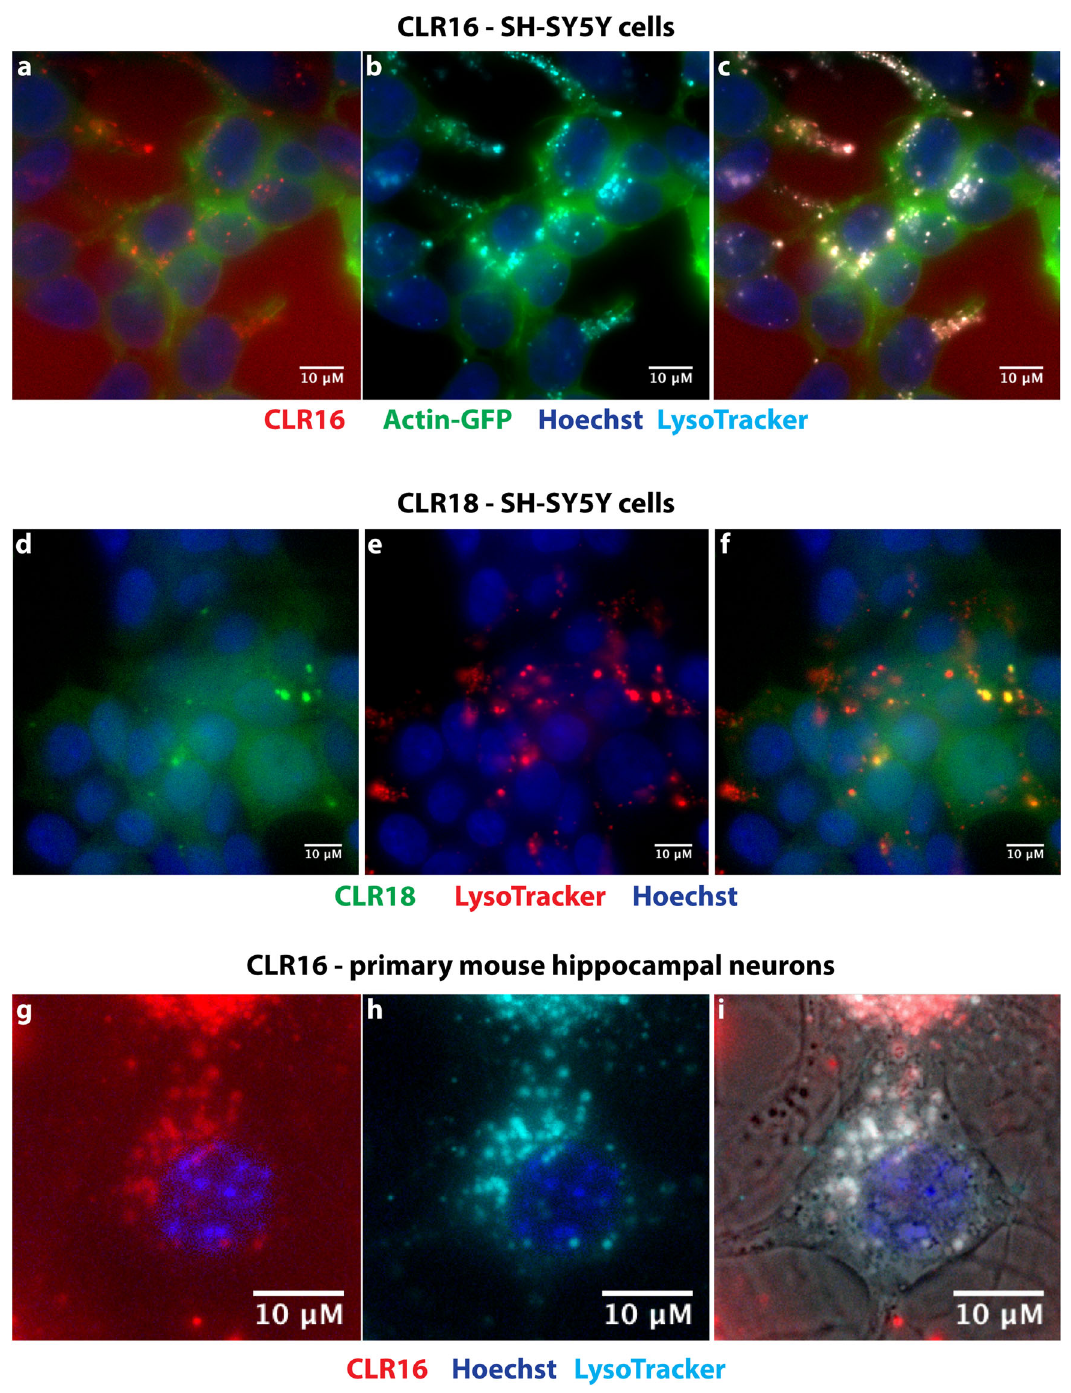
Fig. 4 MTs colocalize strongly with lysosomes in neurons. a SH-SY5Y cells were transiently transfected with GFP-actin, incubated with 5 µ M CLR16 for 24 h, and nuclei were stained with Hoechst. b Lysosomes were stained with LysoTracker ™ (pseudo-colored cyan). c Overlap of a and b shows strong colocalization of CLR16 with lysosomes. d SH-SY5Y cells were incubated with 10 µ M CLR18 for 24 h and nuclei were stained with Hoechst. e Lysosomes were stained with LysoTracker ™ (pseudo-colored red). f Overlap of d and e shows colocalization of CLR18 with lysosomes. g Primary mouse hippocampal neurons were incubated with 10 µ M CLR16 for 24 h and nuclei were stained with Hoechst. h Lysosomes were stained with LysoTracker ™ (pseudo-colored cyan). i Overlap of g and h shows the colocalization of CLR16 with lysosomes. The neurons ʼ morphology is shown by overlap with the bright fi eld